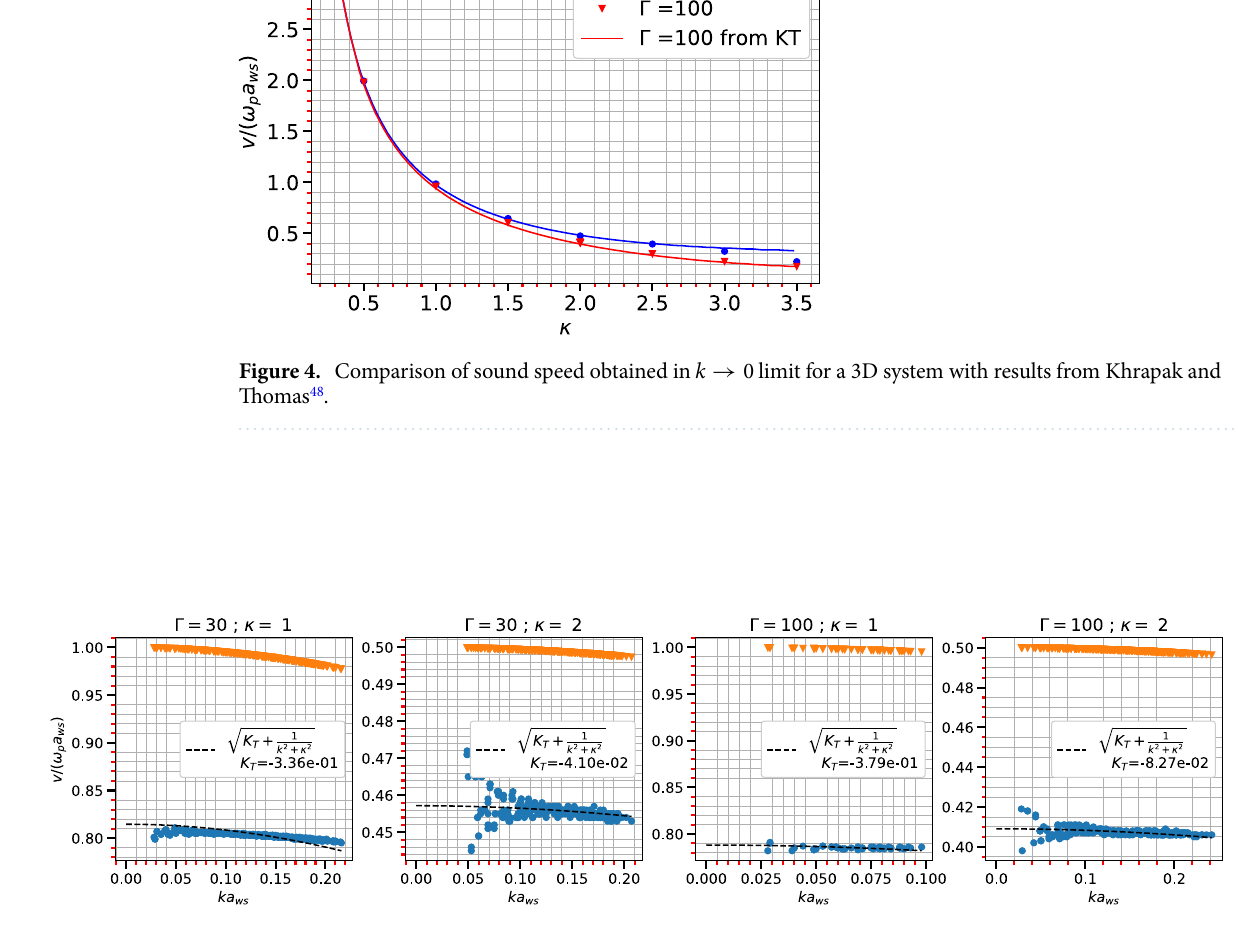
Figure 5. Sound speed ( c s ) with ka ws for different Ŵ and κ in a 2D system. The inverted triangles